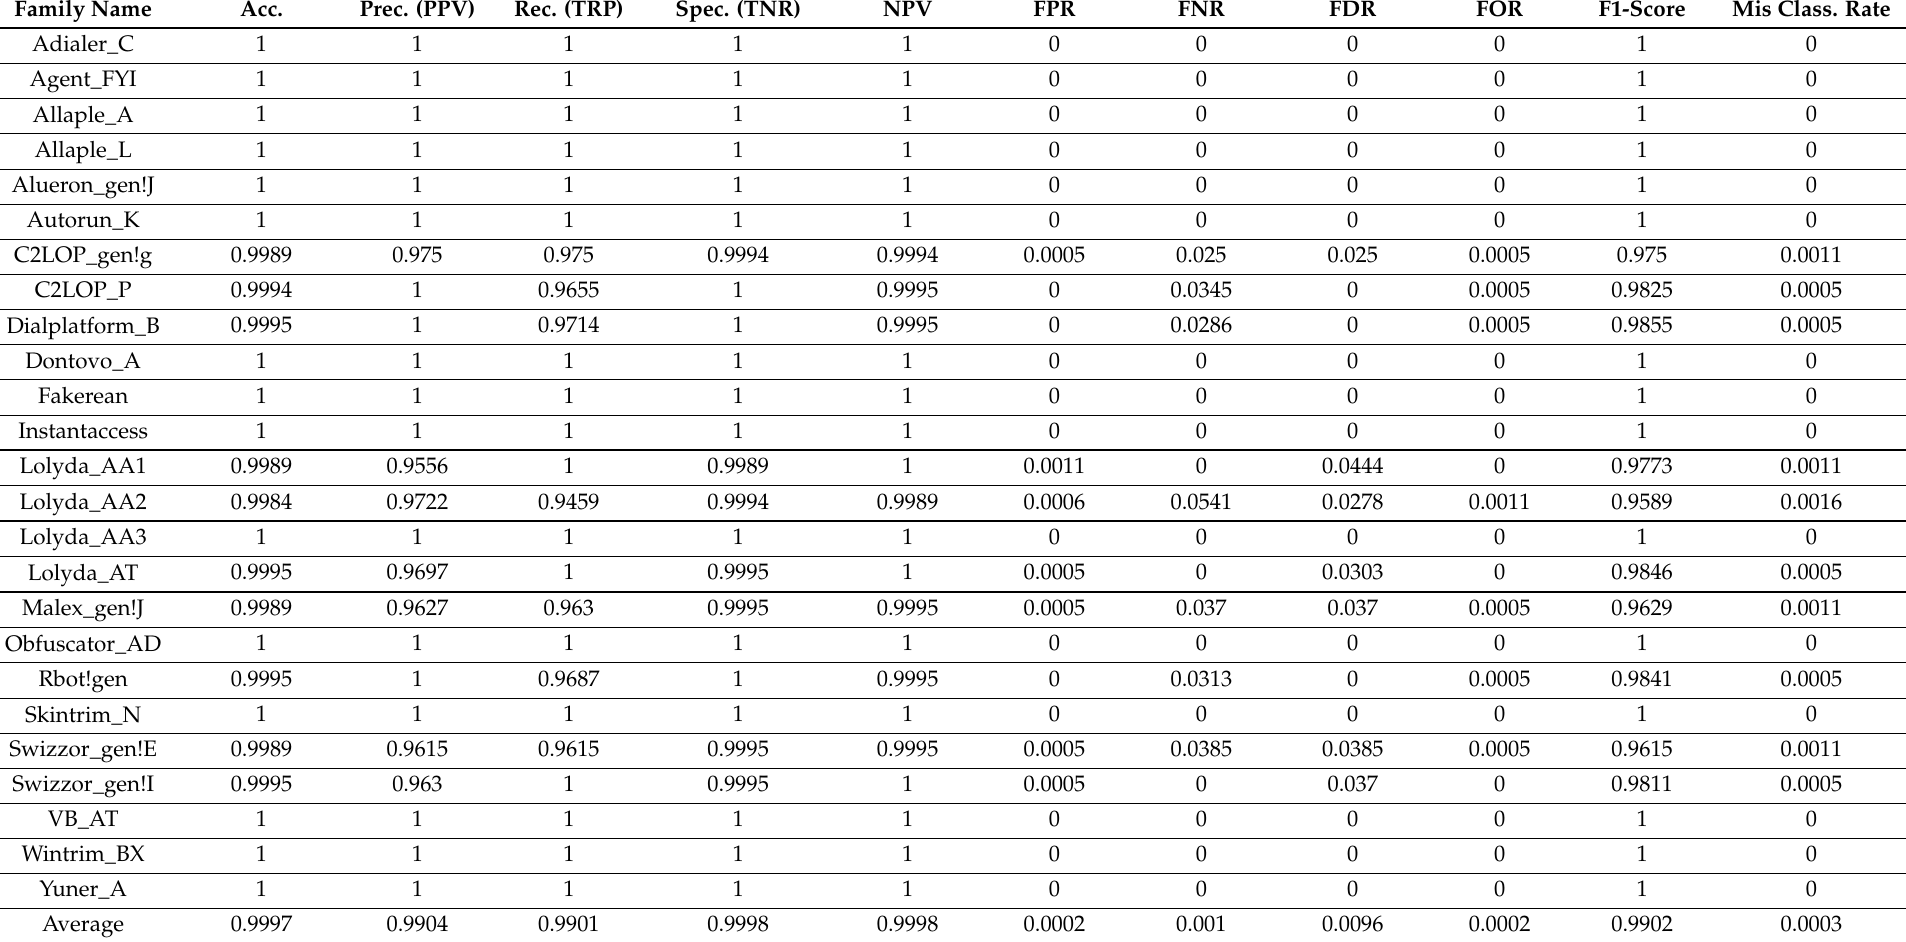
Table 6. Evaluation metrics of the fine-tuned VGG16 classification